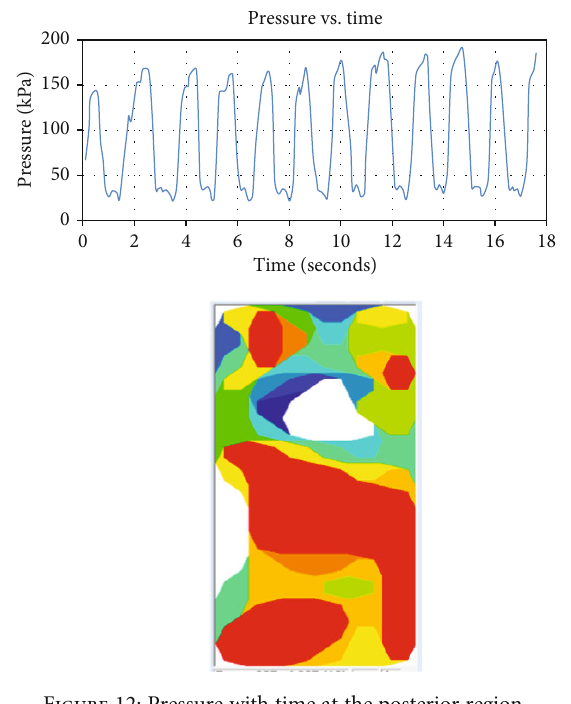
Figure 12: Pressure with time at the posterior region.